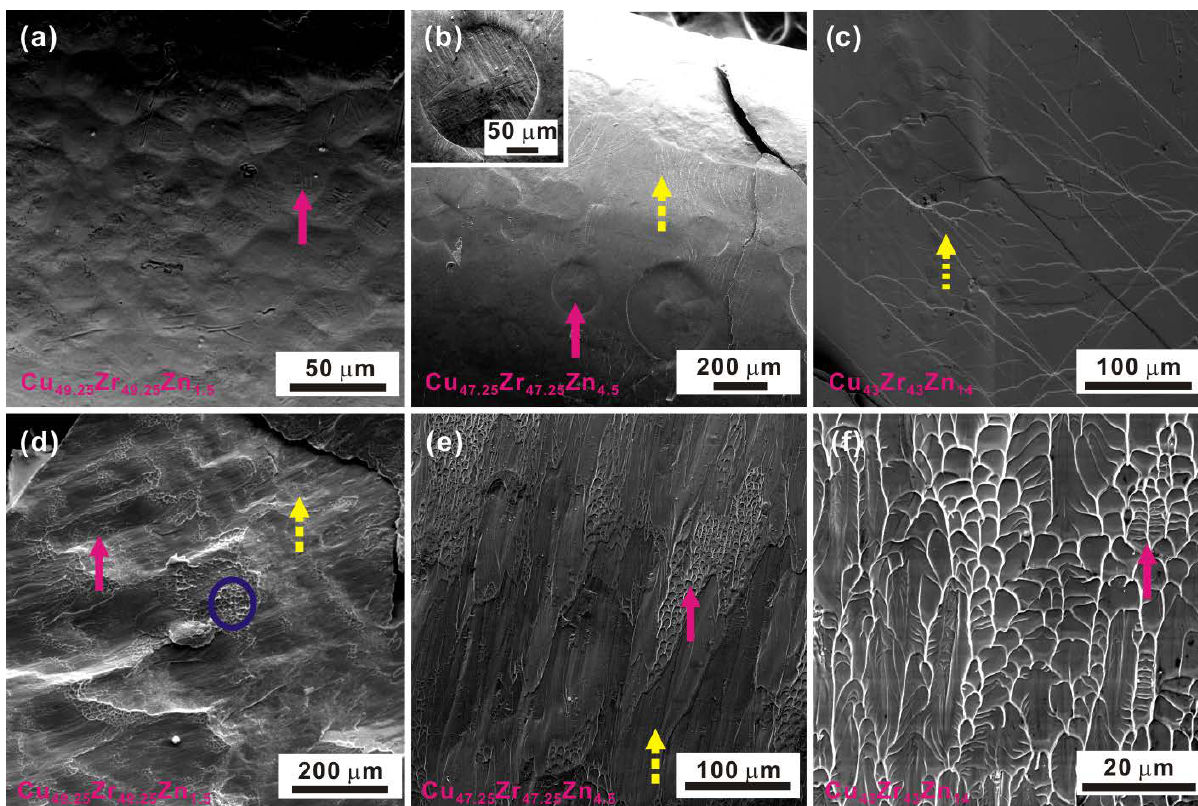
Figure 6. SEM pictures of the external ( a – c ) and fracture ( d – f ) surfaces of the deformed (Cu 0.5 Zr 0.5 ) 100− x Zn x samples: ( a ) x = 1.5 at. %; ( b ) x = 4.5 at. %; ( c ) x = 10 at. %; ( d ) x = 1.5 at. %; ( e ) x = 4.5 at. %; and ( f ) x = 14 at. %. Inset: martensitic plates within the B2 CuZr